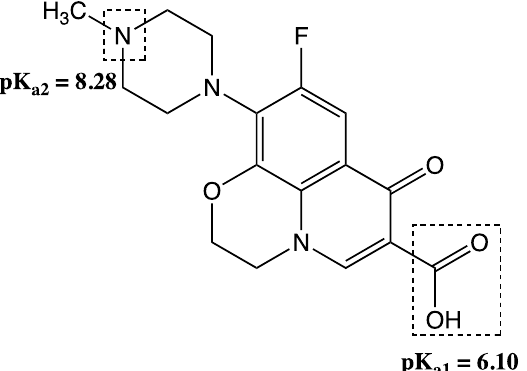
Figure 11. Chemical structure of OFL. The pH responsive moieties (3-carboxyl and piperazinyl groups) are denoted in dashed squares.